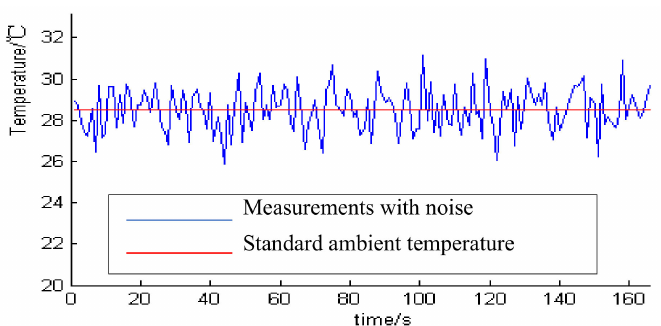
Figure 9. Temperature observation with random noise of constant temperature water bath.